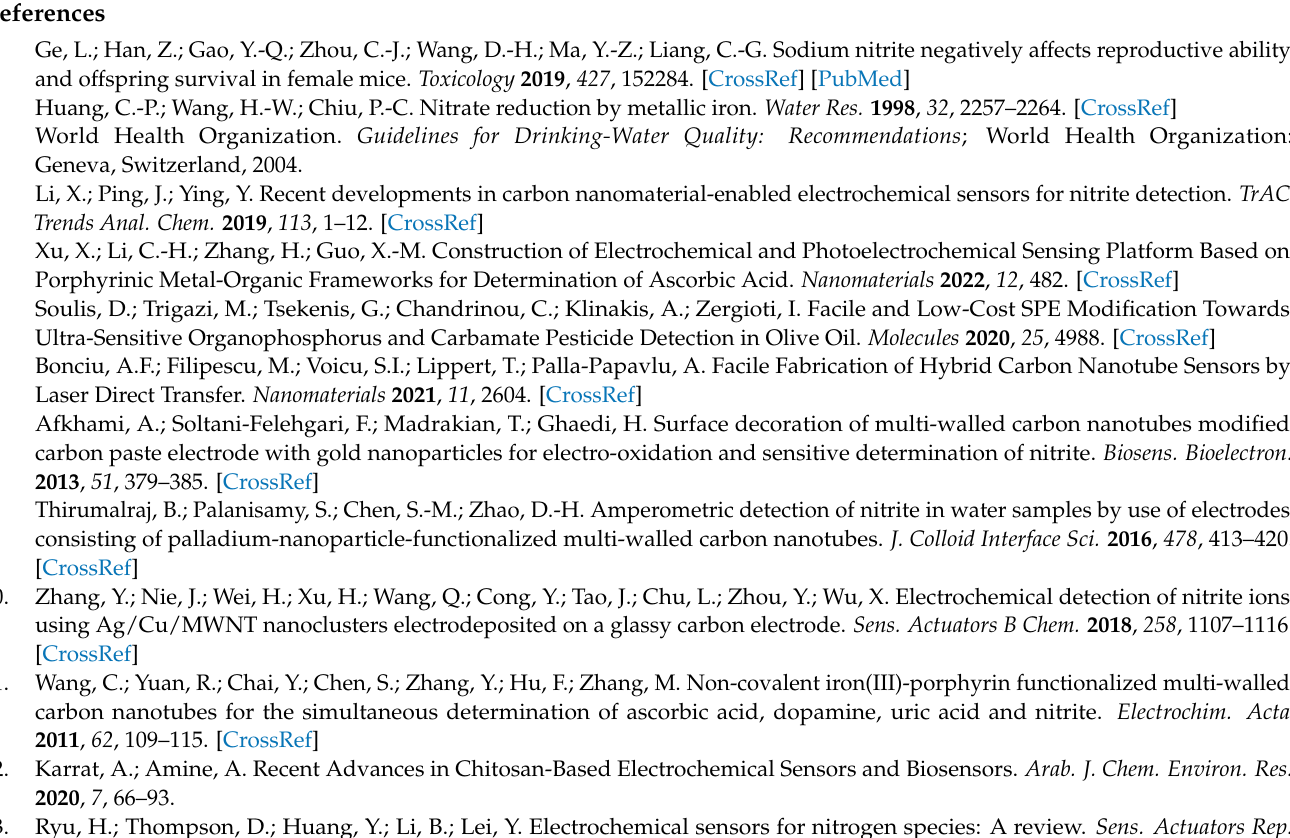
Figure S3. AFM images of the samples A, B, C and D. Figure S4. EDS spectrum of the MAPLE processed coatings. Figure S5. SEM images of the CNT-Chit-FePc coatings obtained on Si(100) by MAPLE from targets with different compositions: (a) 15% CNT + 1% Chit + 1% FePc in H 2 O